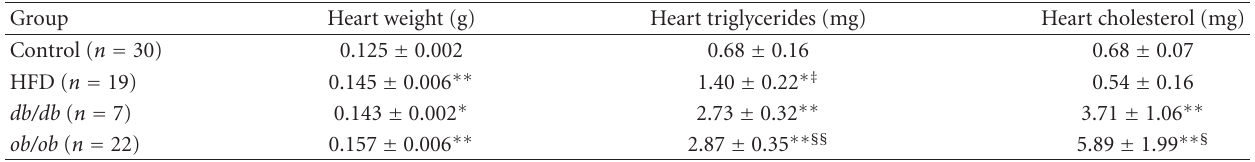
Table 1: Heart weights and lipid content. Heart weights and cardiac triglyceride and cholesterol content were measured. Data reported as mean ± SE. Results of ANOVA, followed by post hoc t -tests.